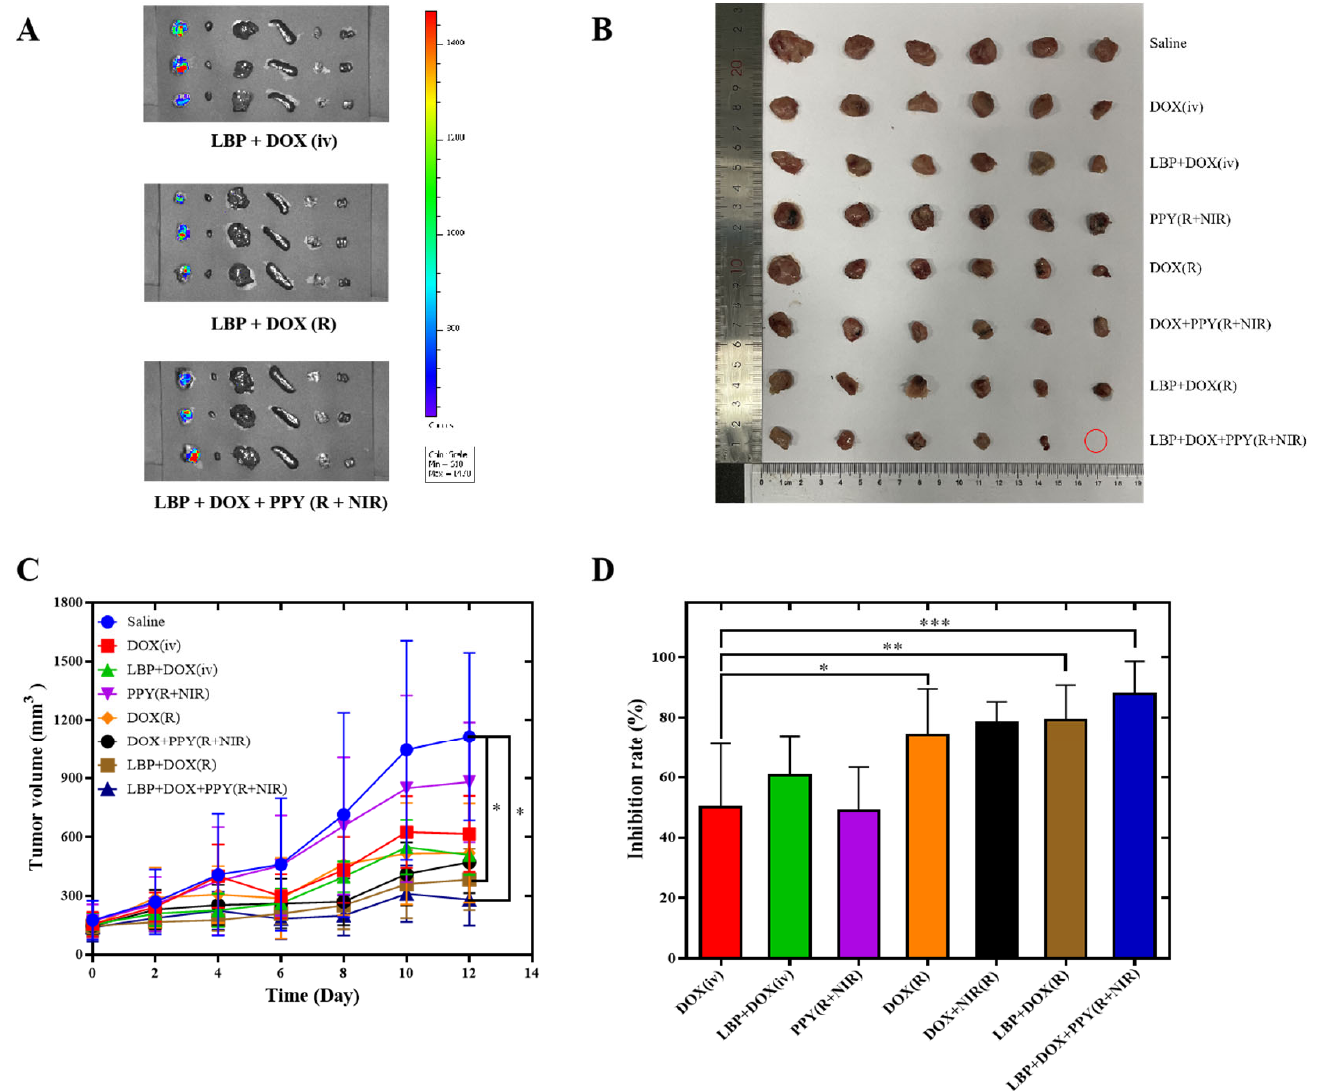
Figure 4. Distribution of DOX and LBP with different routes of administration and delivery forms in different tissues of 4T1 tumor-bearing mice. From left to right in the picture: tumors, hearts, livers, spleens, lungs, and kidneys (n = 3) ( A ); anatomical diagram of all groups of solid tumors at the end of the experiment ( B ); tumor growth curves ( C ) (mean ± SD, n = 6); tumor inhibition rate ( D ) (mean ± SD, n = 6). * p < 0.05, ** p < 0.01, *** p < 0.001.